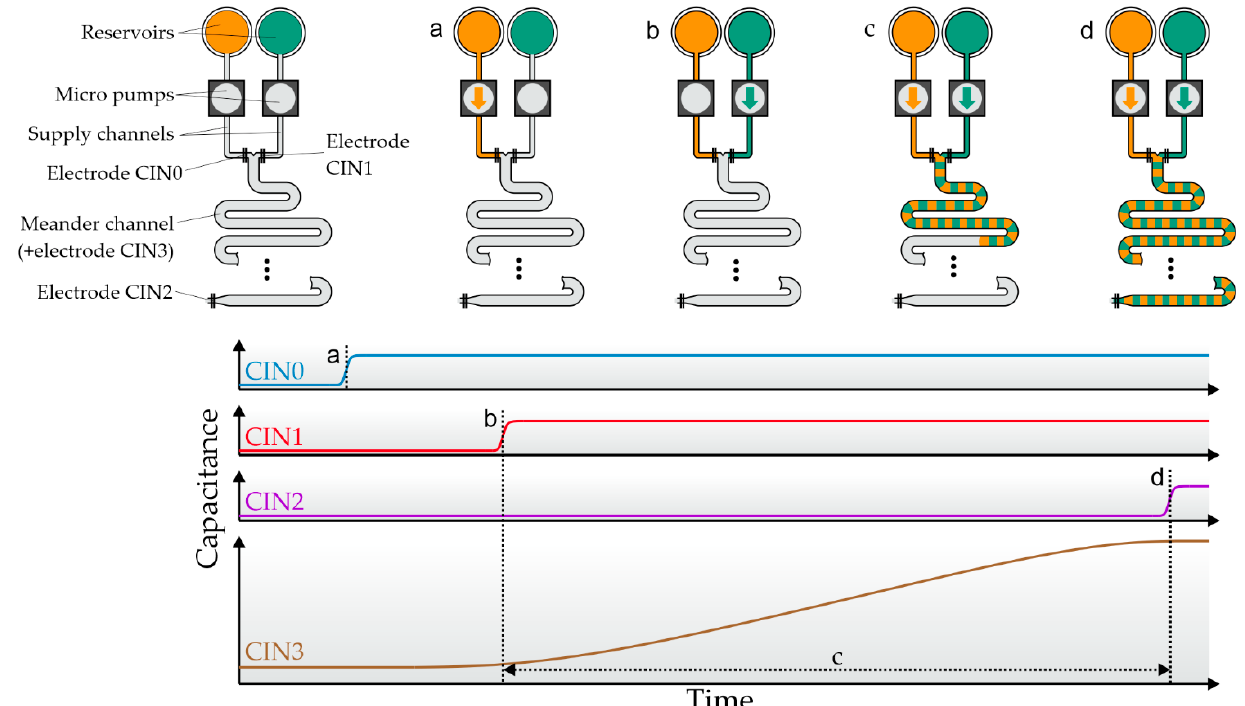
Figure 2. Schematic flow process and capacitance measurements during a complete dosing process in one meander. Four electrodes are used for fluid control, named CIN0 and CIN1 (at the end of the supply channels), CIN2 (at the end of the meander), and CIN3 (which covers the complete meander, not depicted). ( a ) Filling of the first supply channel. Filling is completed when digital electrode CIN0 detects fluid. ( b ) The second supply channel is full when CIN1 is triggered. ( c ) Alternating pumping. The capacitance of the main meander electrode is used to switch between the pumps. The capacitance gain caused by each pump is saved for later analysis. ( d ) The process finishes when CIN2 is triggered.